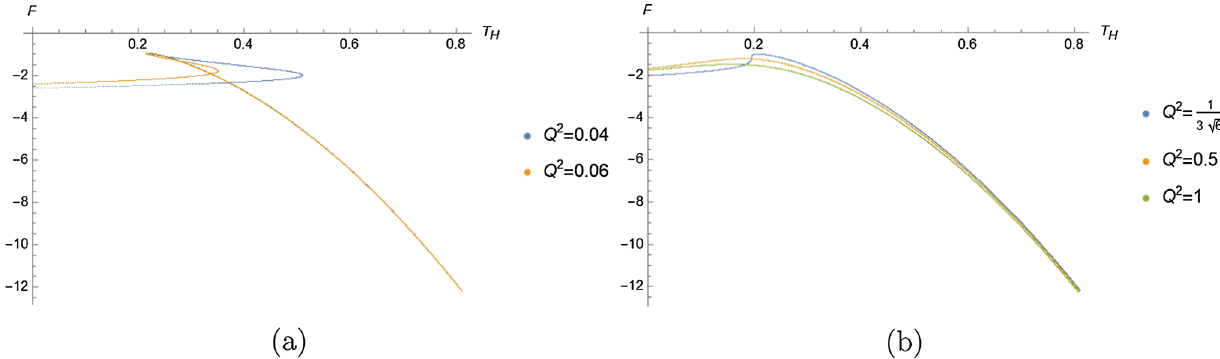
Fig. 6 a The free energy F as a function of temperature T H at Q 2 = 0 . 04 , 0 . 06. b The free energy F as a function of temperature T H at , 0 . 5 , 1 Q 2 = Q 2 crit